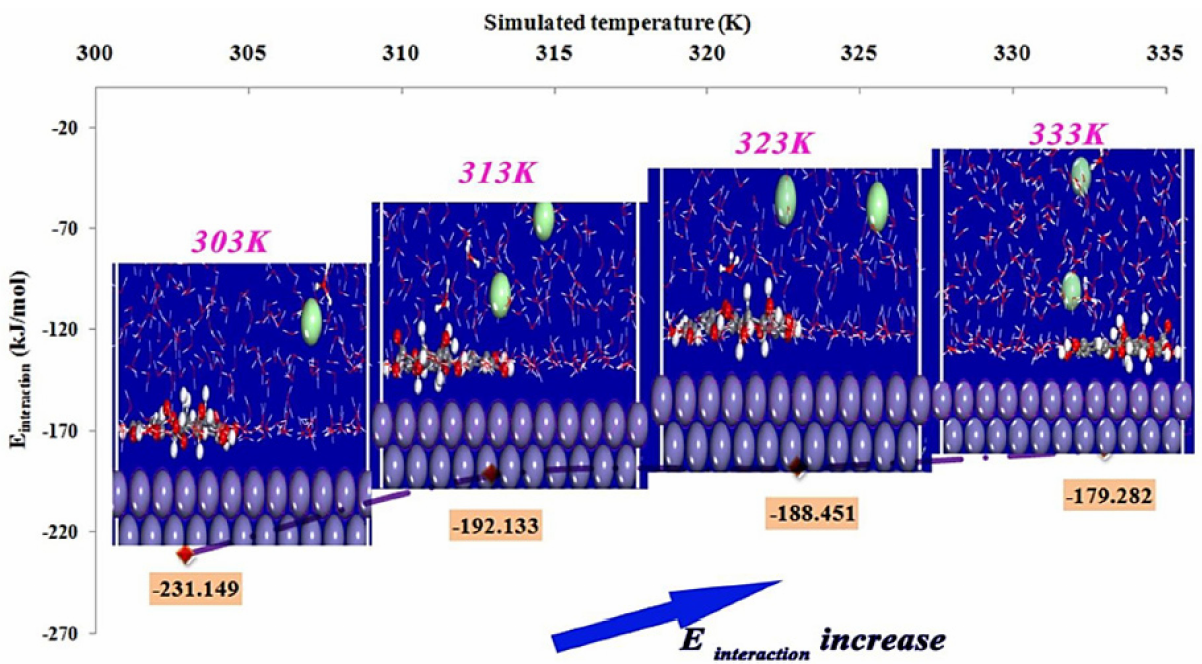
Figure 7. Side view of adsorbed LM molecule on Fe (110) and its interaction energy at different temperatures reproduced from [98], with permission from Elsevier,